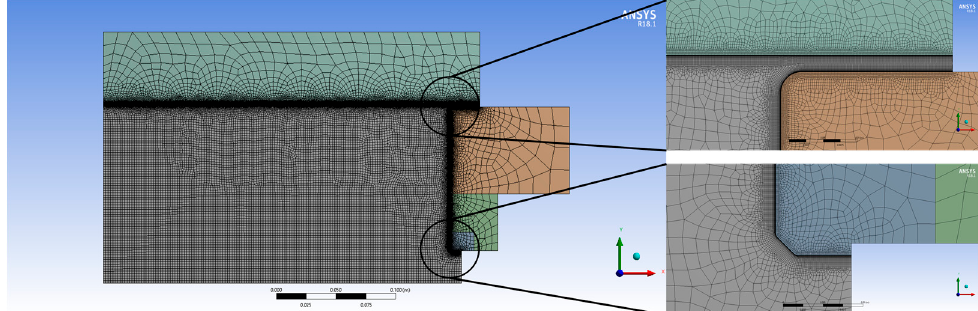
Figure 2. Computational mesh consisting of ~100,000 elements. The mesh is refined near the container and die walls, with 20 layers that span ~1.5 mm; the wall adjacent layer has a thickness of 10 μ m.